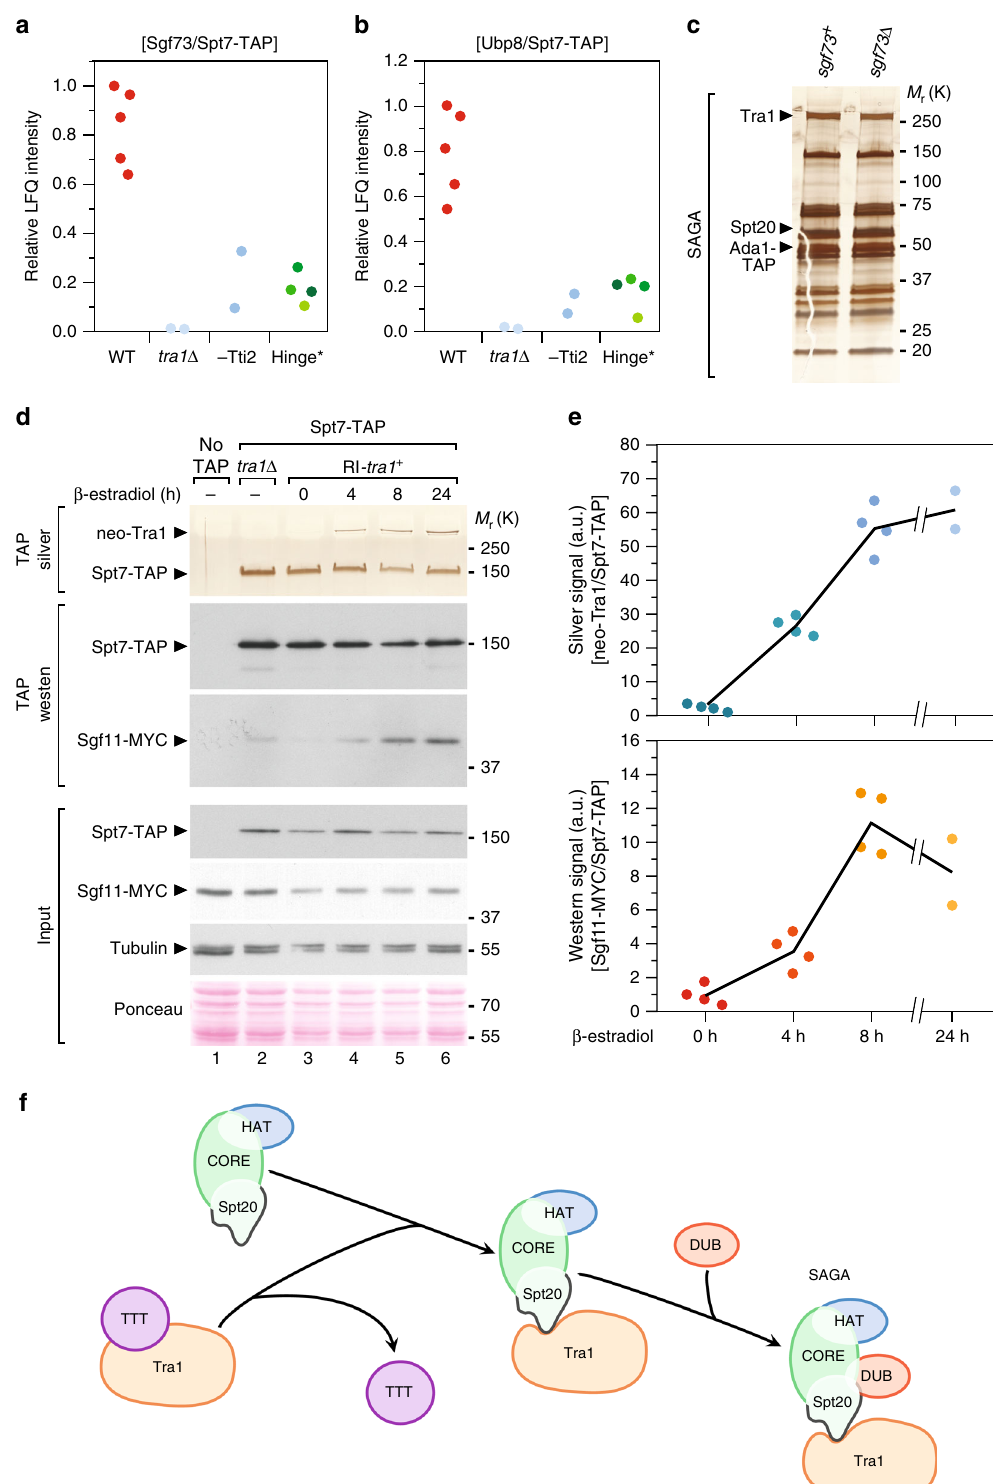
RT-qPCR . Reverse transcription and quantitative PCR analyses of cDNA were performed using RNA extracted from 50mL of exponentially growing cells, as described 57 , and according to the MIQE guidelines 58 . Brie fl y, the total RNA was puri fi ed using hot, acidic phenol, and contaminating DNA was removed by DNase I digestion, using the TURBO DNA-free ™ kit (AM1907, Ambion). One microgram of RNA was then reverse-transcribed (RT) at 55°C with random hexanucleotide primers, using the SuperScript III First-Strand System (18080051, Thermo Fisher